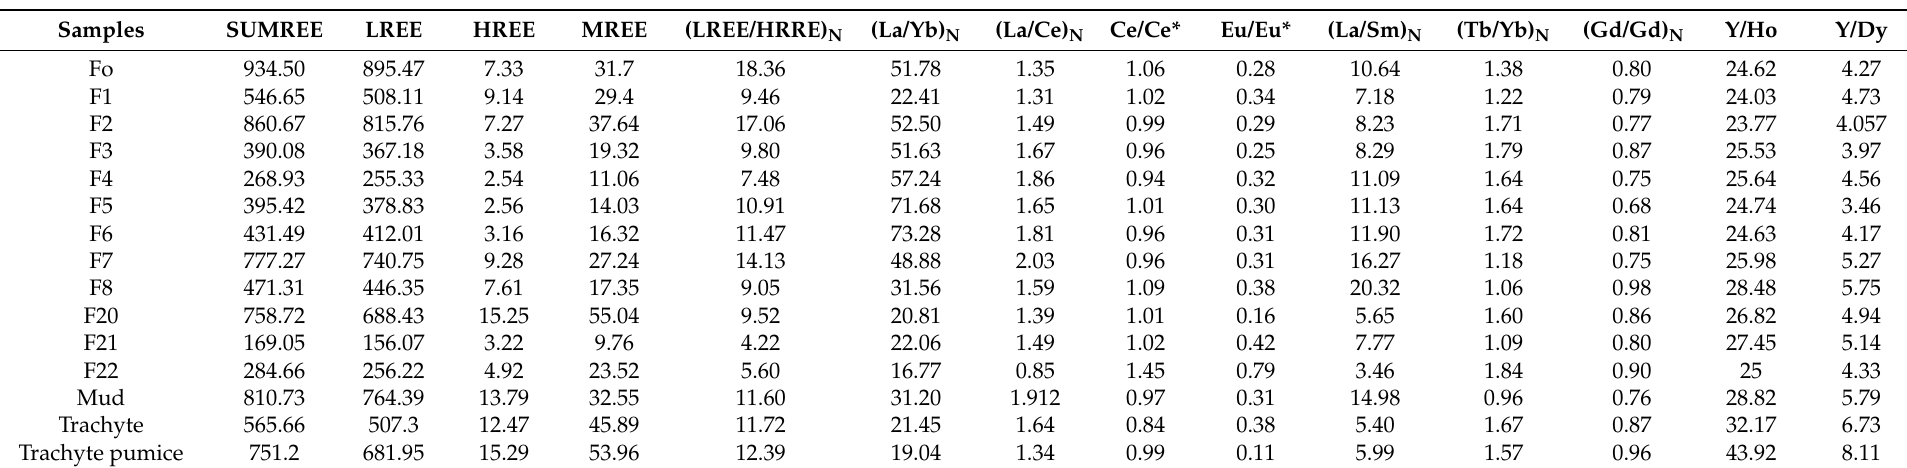
Table 5. Sum of the REE concentrations and REE chondrite normalized